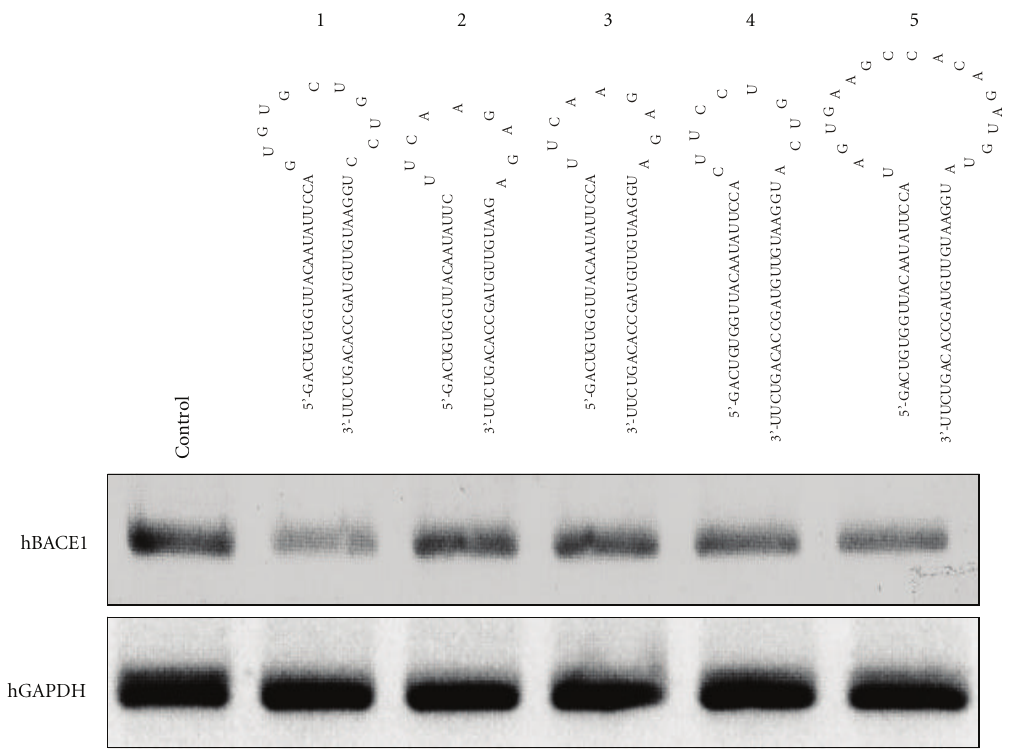
Figure 3: Optimizing of the loop sequence of si-6-based shRNA in HEK293 cells, as evaluated by RT-PCR: (1) pcPURhU6 si-6 (21bp)- miR26, (2) si-6 (19bp) with 9-nt UUCAAGAGA loop, (3) si-6 (21 bp) with 9-nt UUCAAGAGA loop, (4) si-6 (21bp) with 10-nt CUUCCUGUCA (loop from miRNA23), and (5) si-6 (21bp) with 19-nt UAGUGAAGCCACAGAUGUA (loop from